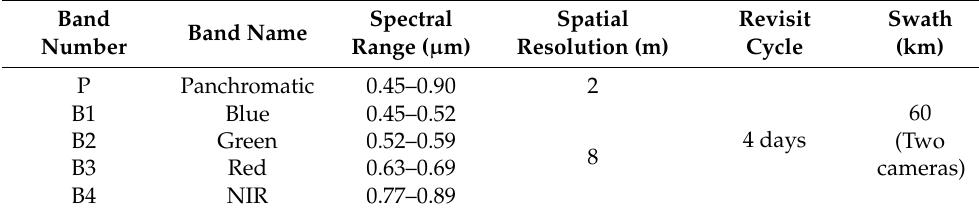
Table 2. Technical parameters of payloads for GF-1